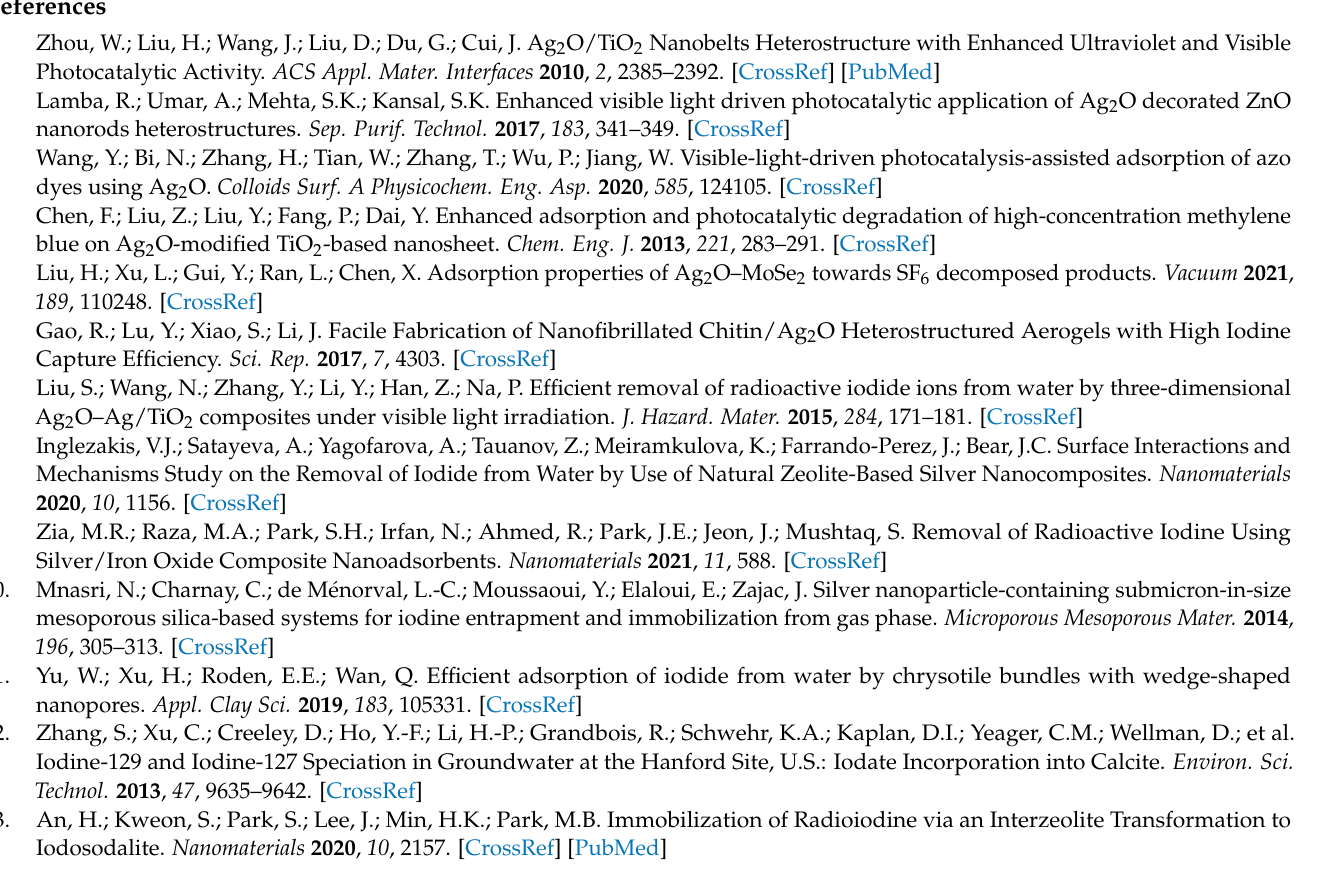
Table S1: Kinetics constants for I − adsorption in various samples; Table S2: Comparison of ad- sorption capacities of different adsorbents for I − . References [11,14,16,39,45–47] are cited in the Supplementary